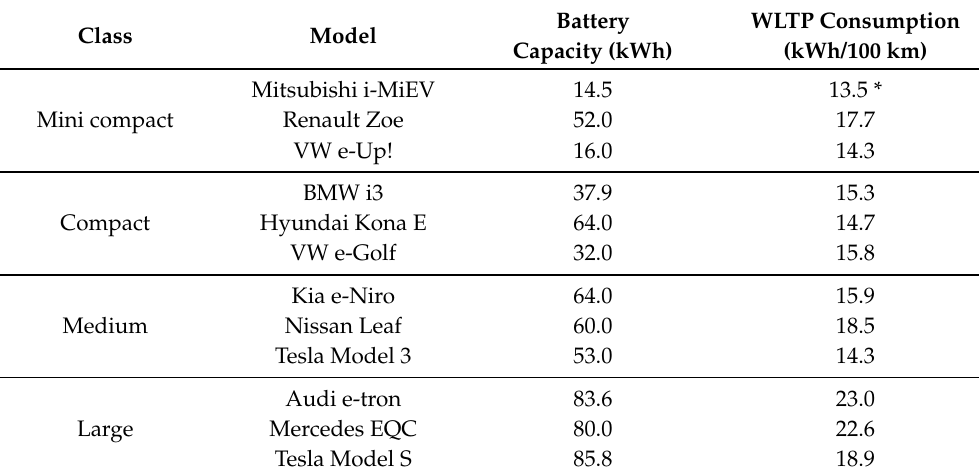
Table A1. Electric reference vehicles. The vehicle data are obtained from databases of the ADAC (Allgemeiner Deutscher Automobil Club), a German motoring association